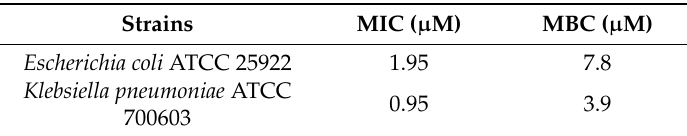
Table 5. The minimal inhibitory concentration (MIC) and minimal bactericidal concentration (MBC) of compound 5e against Escherichia coli and Klebsiella pneumoniae